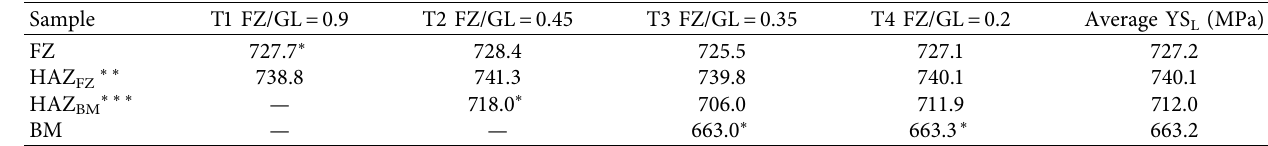
∗ Region of strain localization and failure; ∗∗ region of peak hardness in HAZ close to FZ; ∗∗∗ HAZ just adjacent to BM.